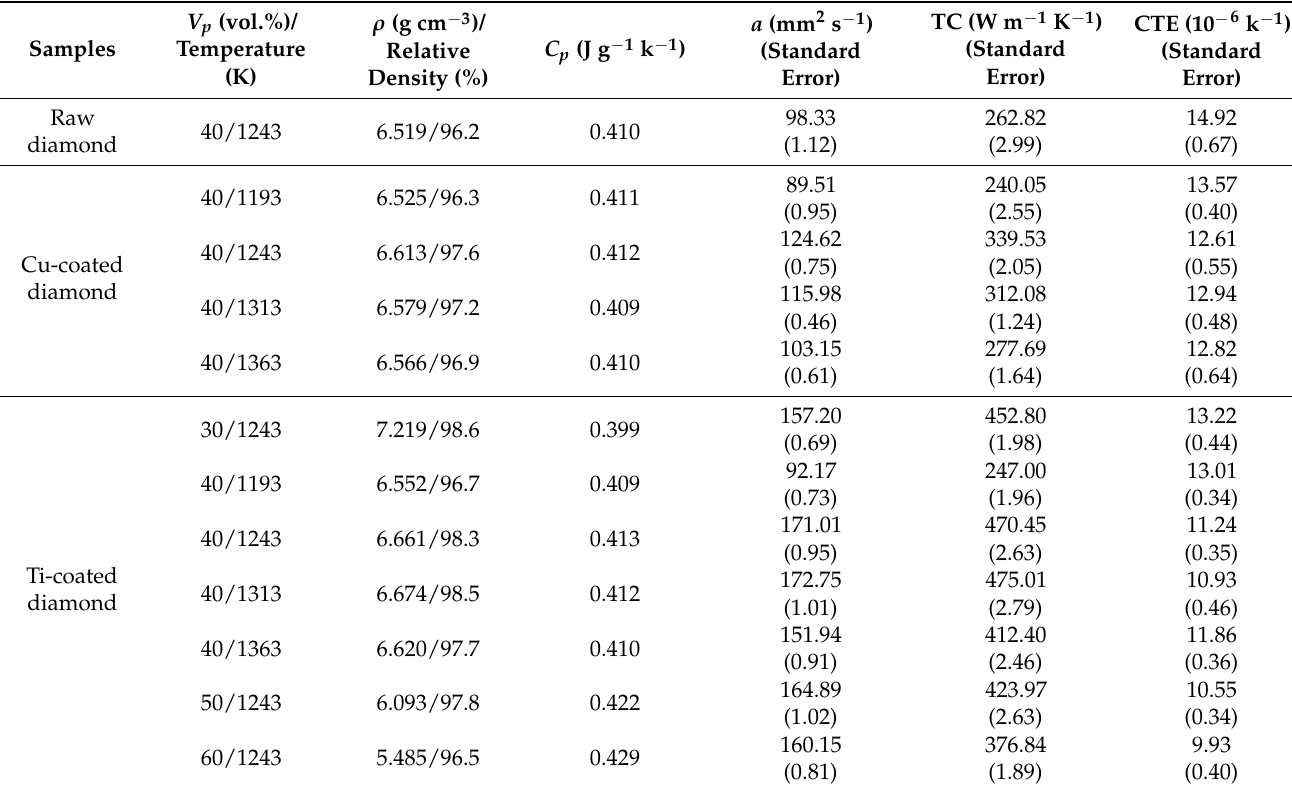
Table 1. Thermal conductivities of the composites prepared under different conditions.